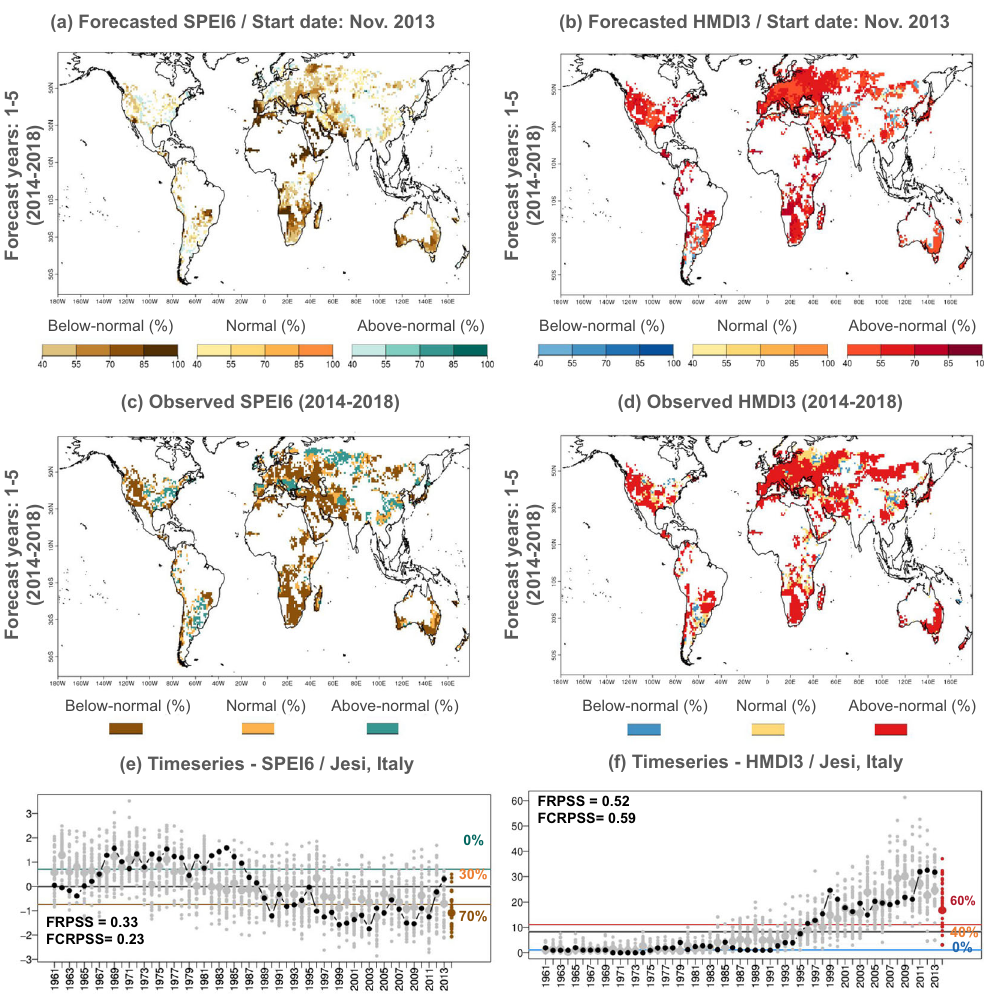
Fig. 6 Climate service product for the wheat sector. Multi-year probabilistic calibrated forecast ( a , b ) and observed ( c , d ) most likely tercile category of SPEI6 (left) and HMDI3 (right) for the year 2014 – 2018 over the wheat harvesting regions that presents positive FRPSS values. Time series of multi-year averaged SPEI6 ( e ) and HMDI3 ( f ) over Jesi, Italy (43.82 ∘ N, 13.75 ∘ E). The small (large) gray dots correspond to the ensemble members of the hindcasts (ensemble members mean) for each start date. The gray horizontal line shows the mean of the hindcast for the whole period (1961 – 2013). The brown (blue) and green (red) horizontal lines show its lower and upper observed terciles of SPEI6 (HMDI3), respectively. The black dots correspond to the observed SPEI6 values. The forecast is issued for the year 2014 – 2018, where the percentages are the fraction of ensemble members falling into each tercile